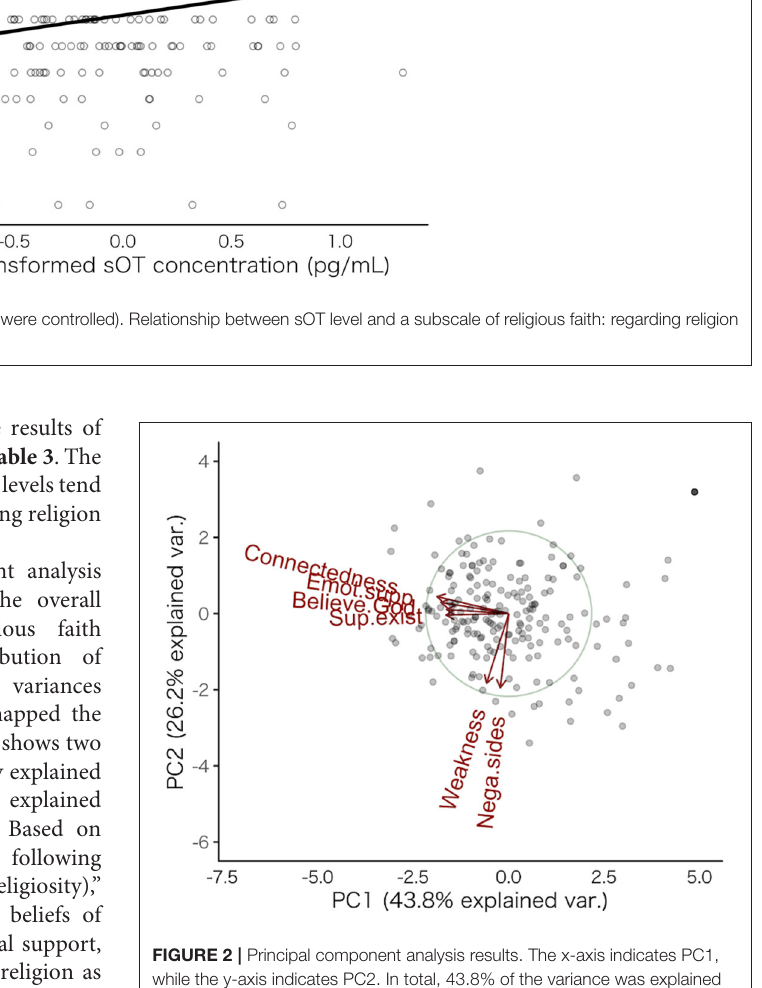
FIGURE 2 | Principal component analysis results. The x-axis indicates PC1, while the y-axis indicates PC2. In total, 43.8% of the variance was explained by PC1, and 26.2% of the variance was explained by PC2. Each red label is an abbreviation of the items (Emot.supp: Regarding religion as emotional support; Believe.God: Believing in the existence of “ Kami (God);” Connectedness: Viewing religion as interconnectedness; Sup.exist: Recognizing the existence of a supreme being; Weakness: Regarding religion as a human weakness; Nega.sides: Indicating the negative sides of religion). PC, principal